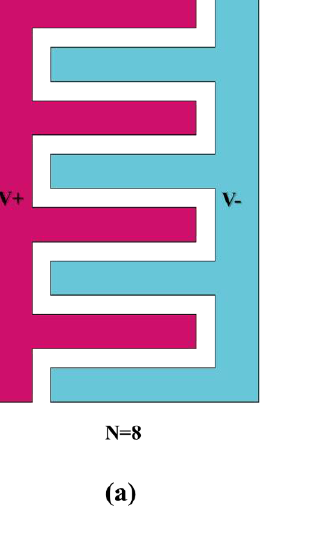
Figure 1. ( a ) Schematic diagram of the basic geometry of an IDTSC. ( b ) Illustration of the force- sensing process of an IDTSC. process of an